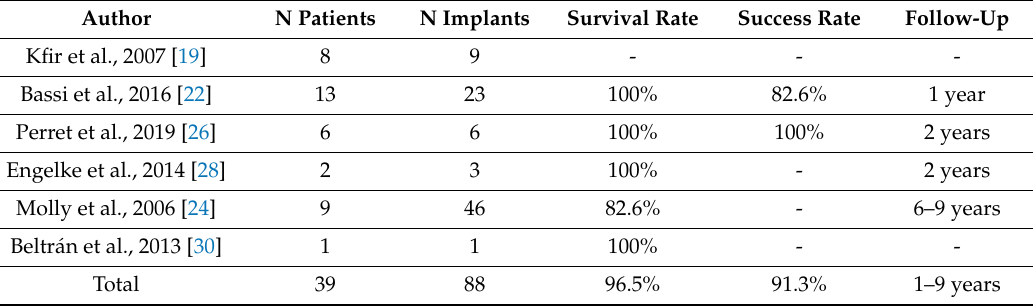
Table 3. Implants survival and success